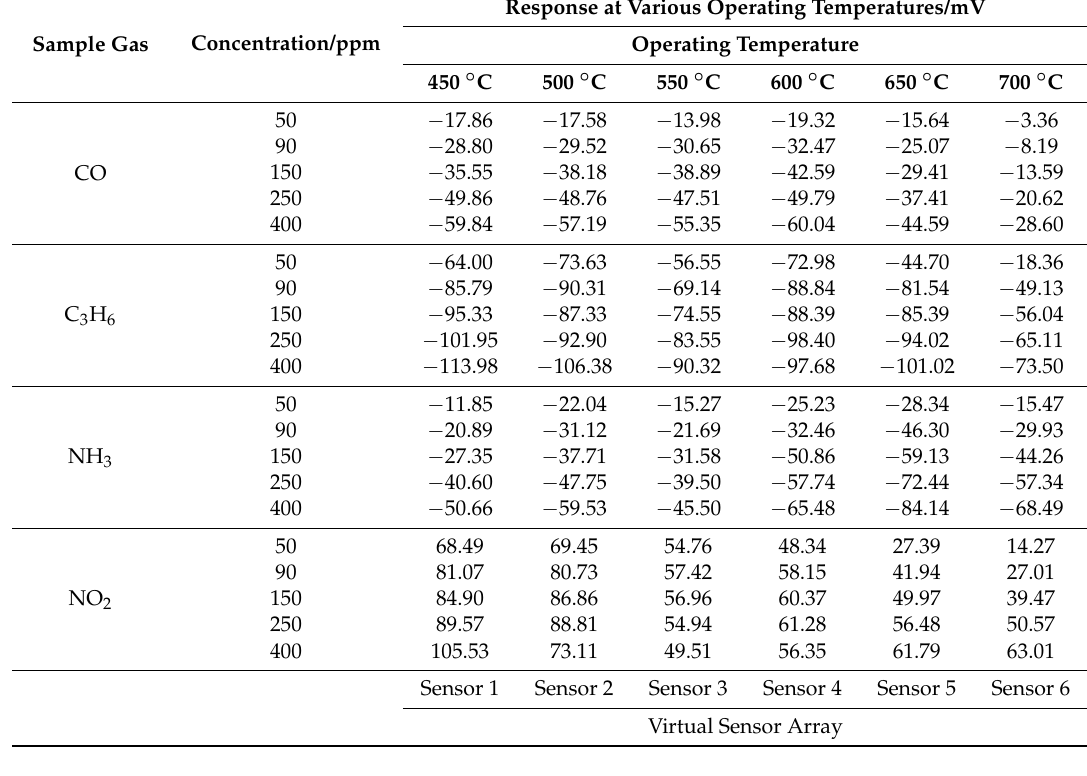
Table 2. The 20 × 6 (row × column) feature vectors being created for PCA analysis.